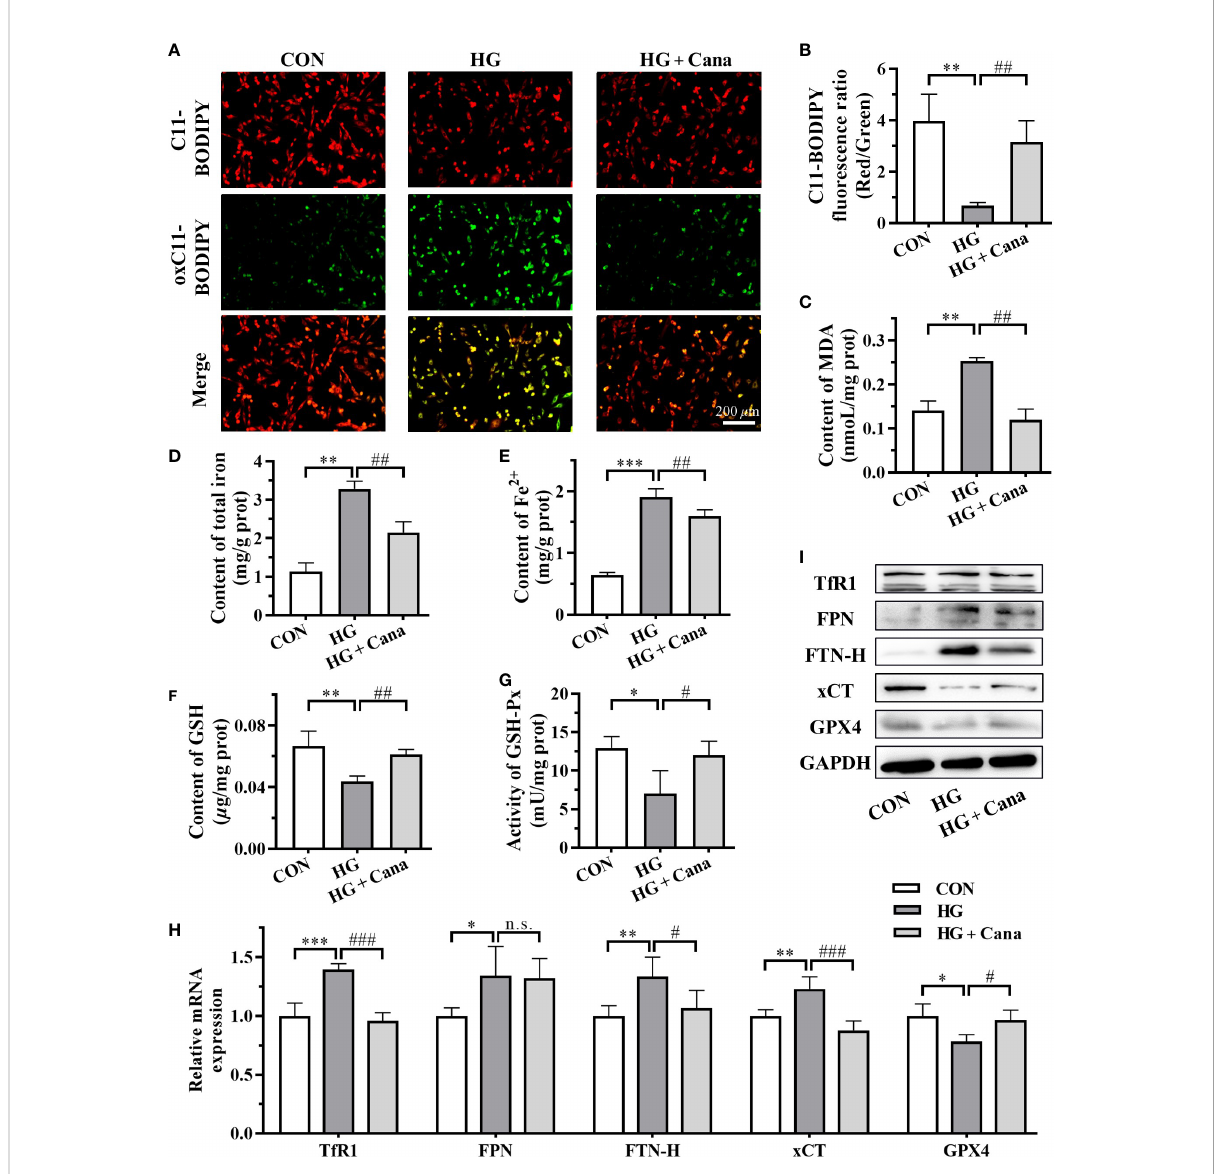
FIGURE 5 Cana mitigates ferroptosis induced by high glucose in cardiomyocytes. (A) The images and (B) C11-BODIPY fl uorescence ratio of lipid ROS (Scale bar: 200 µ m). C11-BODIPY represents the level of staining with the probe (unoxidized), while oxC11- BODIPY (oxidized) represents the level of lipid ROS. Contents of (C) MDA, (D) total iron and (E) Fe 2+ in H9C2 cells. (F) Content of GSH; (G) Activity of GSH-Px in H9C2 cells. (H) Transcriptional level and (I) protein level of ferroptosis related genes examined by qPCR and western blotting assay. ROS: reactive oxygen species; MDA: malondialdehyde. ROS, reactive oxygen species; MDA, malondialdehyde; GSH, glutathione; GSH-Px, glutathione peroxidase; FTN-H, ferritin heavy-chain; xCT, cystine-glutamate antiporter; GPX4, glutathione peroxidase 4; GAPDH, glyceraldehyde-3-phosphate dehydrogenase. (*: P<0.05; **: P<0.01; ***: P<0.001; compared with CON group; #: P<0.05; ##: P<0.01; ###: P<0.001; compared with HG group; n.s.: no signi fi